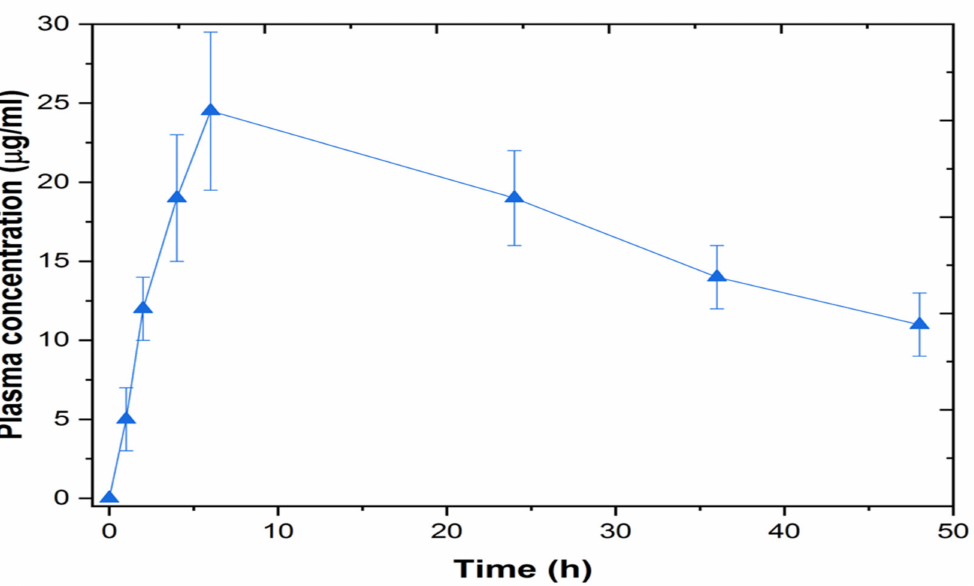
Figure 16. Graph showing the plasma concentration–time profile of LS-TC-MNP-3 fabricated with thiolated chitosan (applied on the back of the mouse) (Mean ± SD, n = 4). As a result of absorption of interstitial fluid, the thiolated chitosan swells more and more, releasing the drug into the skin and bloodstream. Therefore, the concentration in- creased to 24.5 ± 1.57 µ g/mL after six hours and then slightly decreased to 19 ± 1.69 µ g/mL after 24